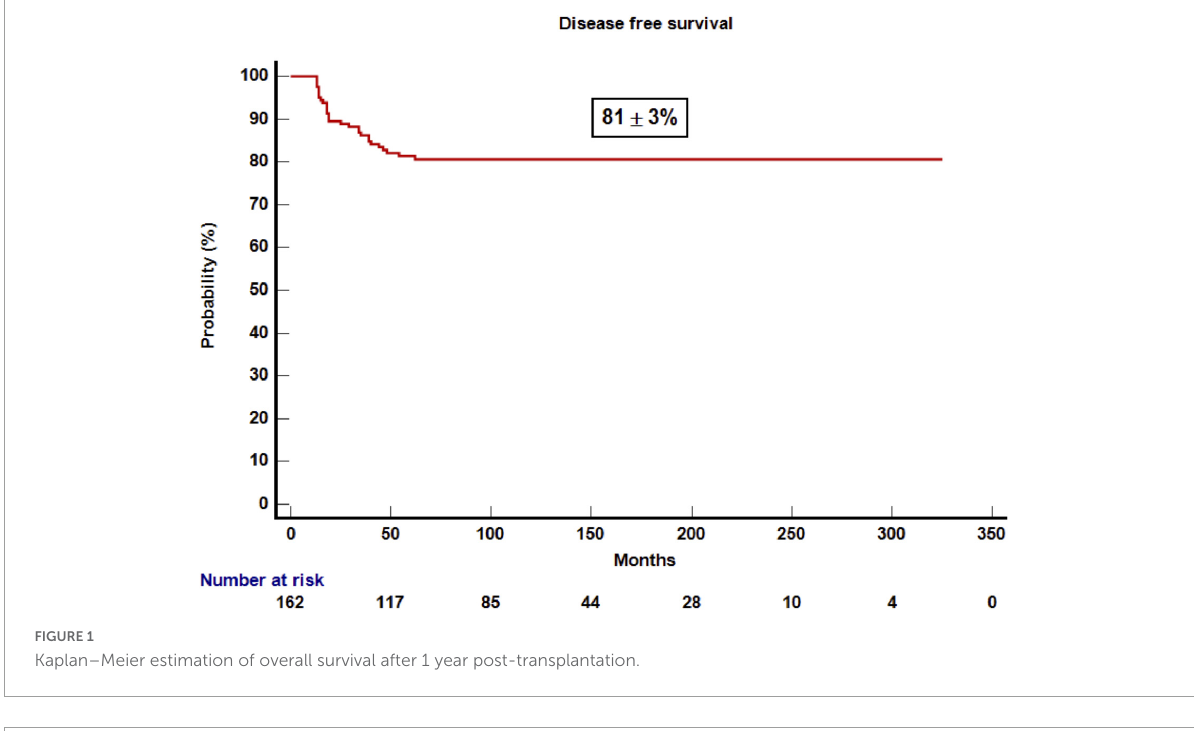
FIGURE1 Kaplan–Meier estimation of overall survival after 1 year post-transplantation.